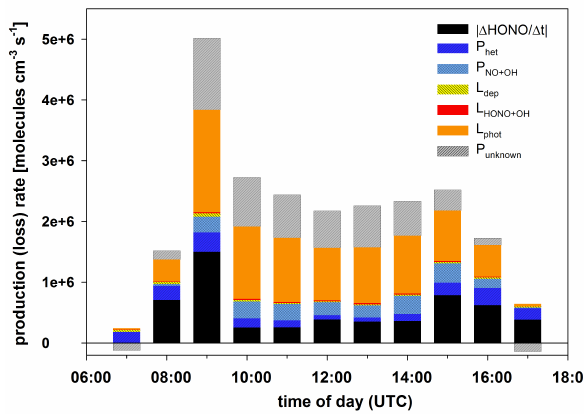
Fig. 3. Contributions of production (bluish colours) and loss terms (hourly means 21 November to 5 December) as well as the unknown daytime HONO source P unknown from Eq. (3).